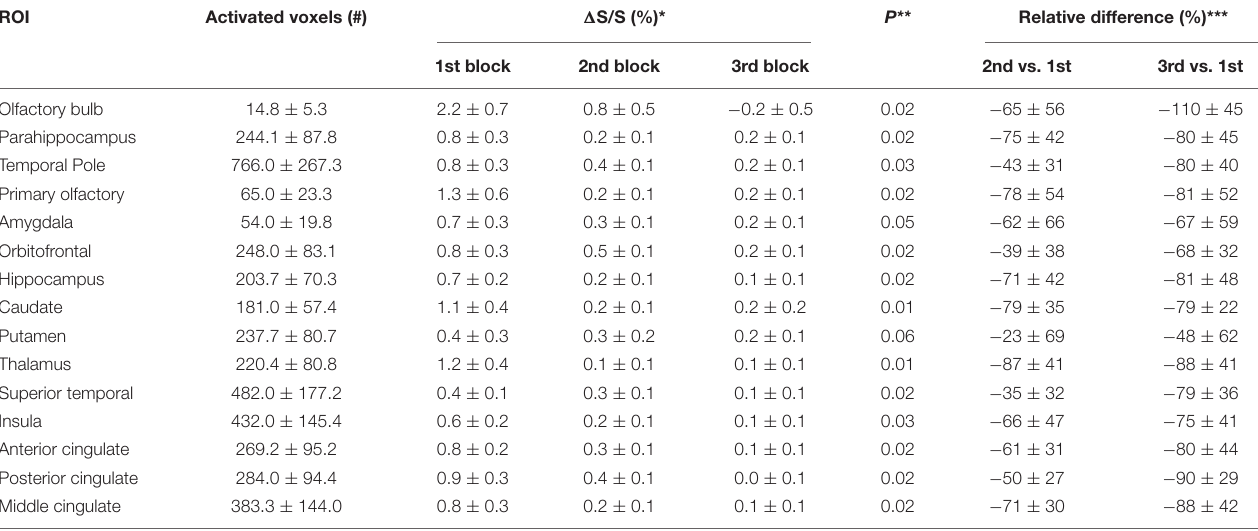
TABLE 2 | Quantitative T2prep BOLD fMRI results from positively activated voxels from all subjects ( n = 14). ROI Activated voxels (#) (cid:49) S/S (%)* P** Relative difference (%)*** 1st block 2nd block 3rd block 2nd vs. 1st 3rd vs. 1st